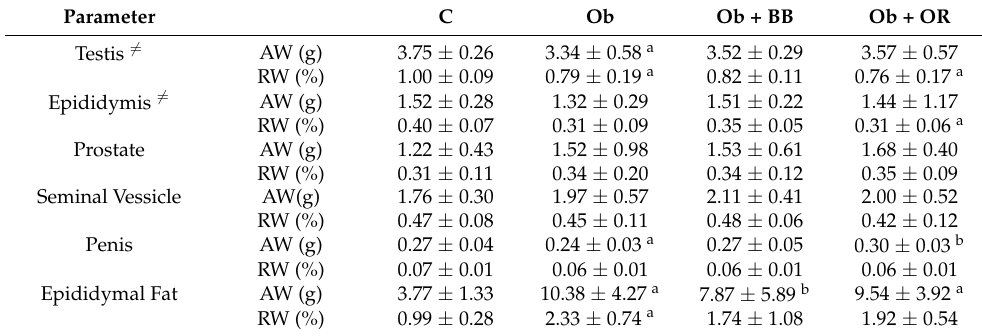
Table 4. Reproductive organs and epididymal fat weights in all groups.